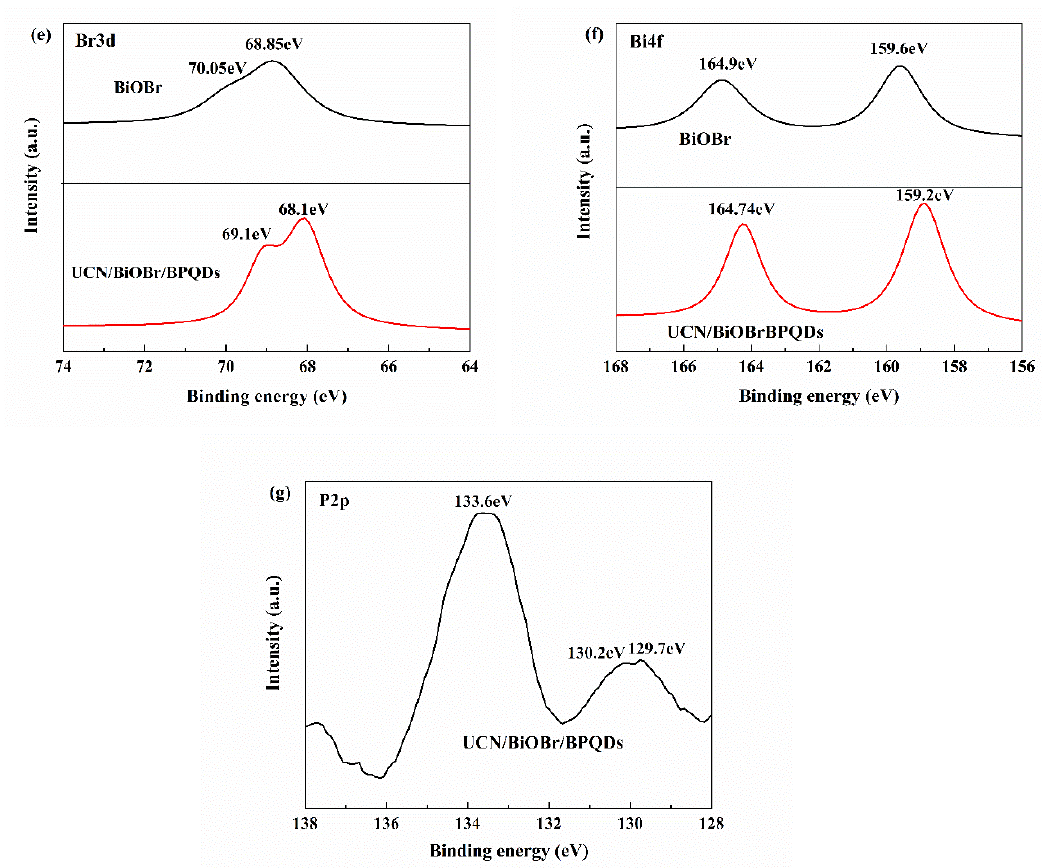
Figure 5. XPS of UCN, BiOBr, and BiOBr/UCN/BPQDs. ( a ) survey; ( b ) C1s; ( c ) N1s; ( d ) O1s; ( e ) Br3d; ( f ) Bi4f; ( g ) P2p.